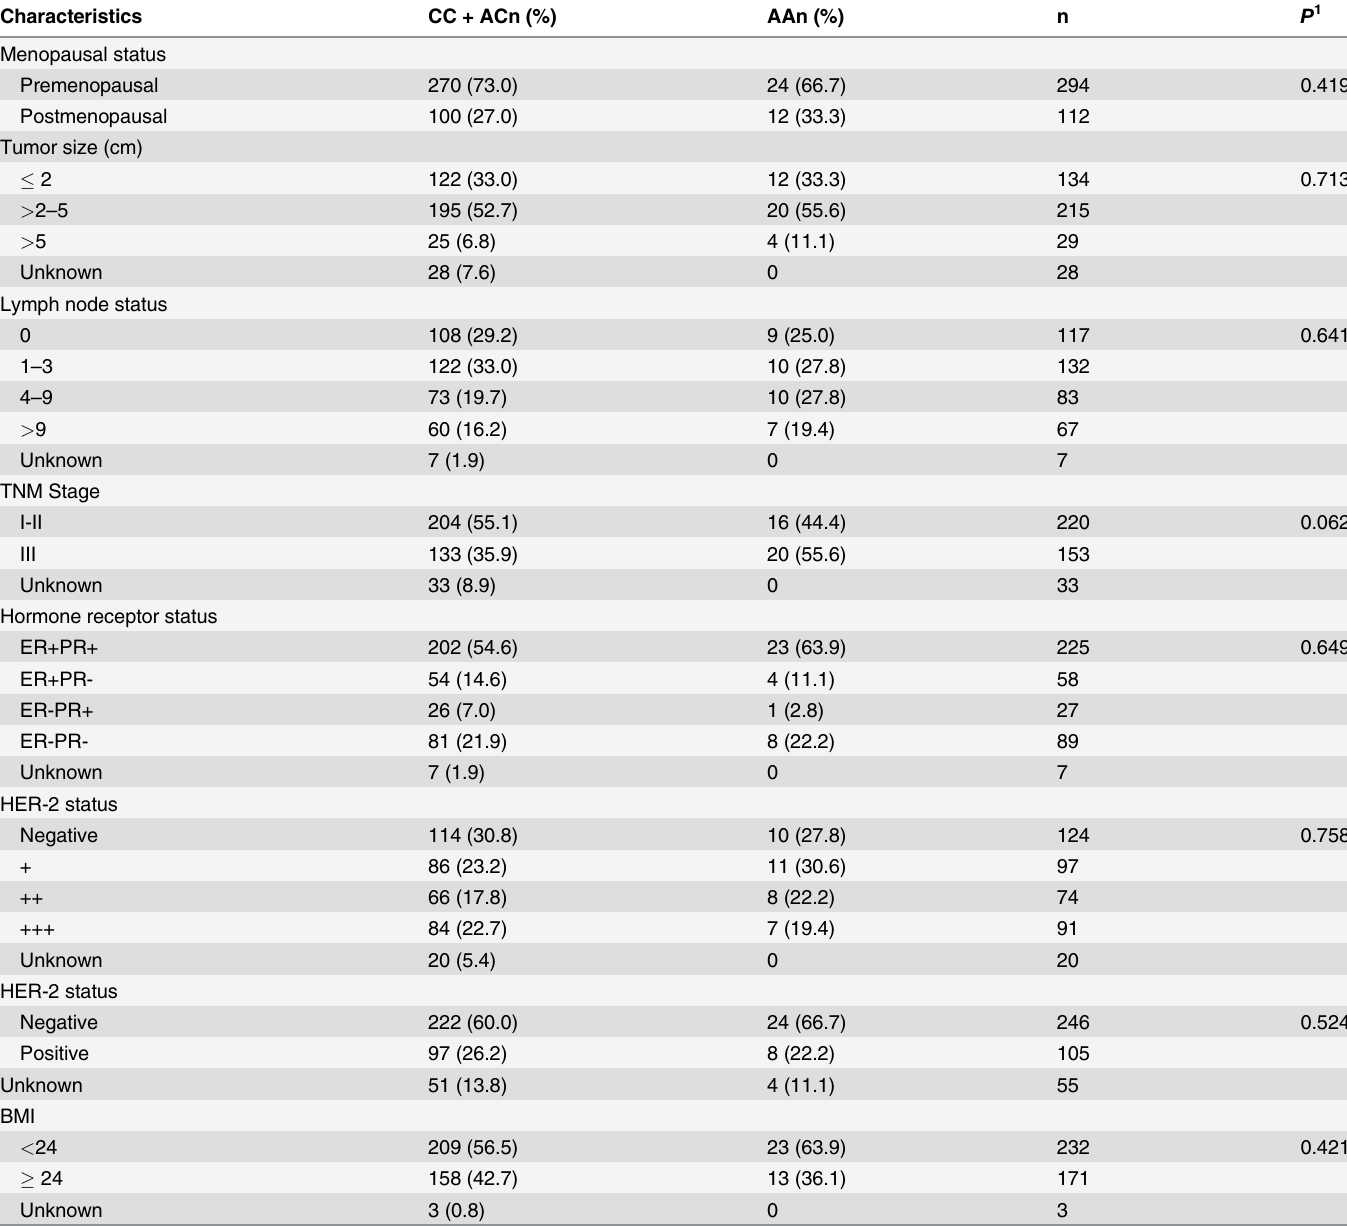
Table 3. Relationship of CYP19 genotypes (CC + AC vs AA) with clinical characteristics.